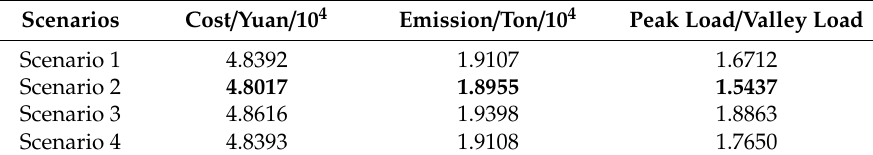
Figure 6. Load demand of four scenarios. Table 4. Optimal compromise solutions of four charging scenarios.